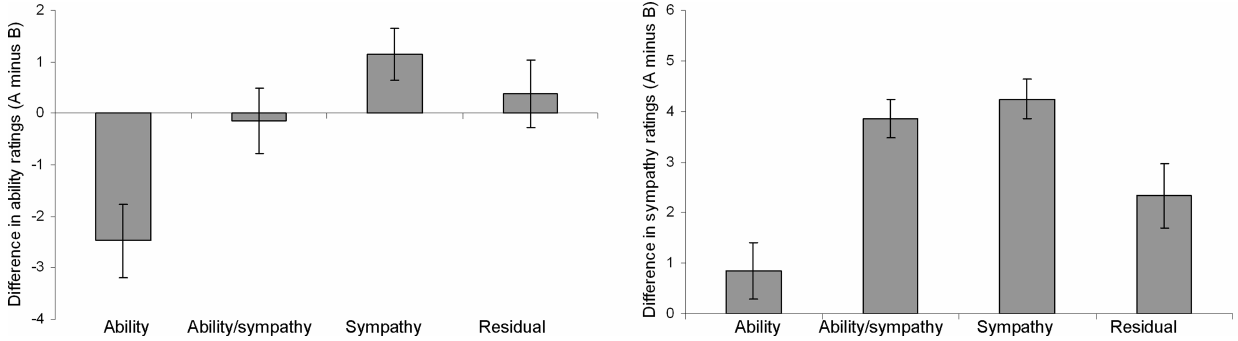
Figure 2. Participants’ ratings of the students’ ability (left side) and the teacher’s sympathy for the students (right side) depending on participants’ previously reported reason for the teacher’s behavior (praising student A, but blaming student